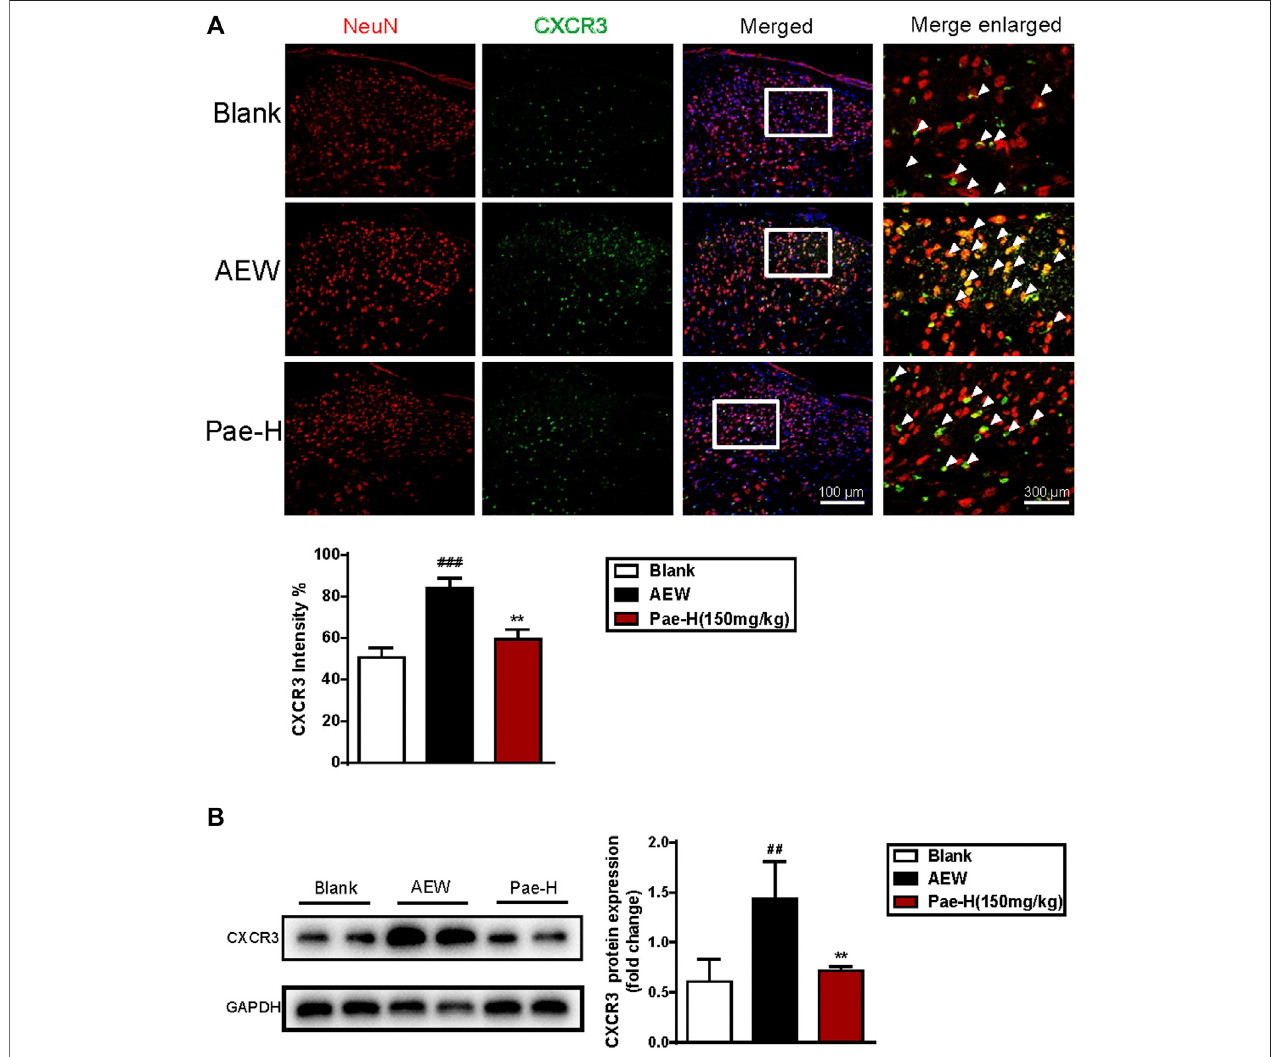
FIGURE 6 | Paeonol decreased the expression of CXCR3 in the spinal neurons of AEW group. (A) The results of immuno fl uorescence indicated paeonol downregulated the CXCR3 + NeuN + double-positive cell ratio in the AEW spinal cord ( n (cid:1) 4 each group). (B) The results of western blot demonstrated paeonol reduced theproteinlevelofspinalCXCR3inAEWmodelgroup( n (cid:1) 4eachgroup).Datawereexpressedasmean ± SEM. ## p < 0.01, ### p < 0.001,comparedtotheblankgroup; pp p < 0.01, compared to the AEW model group.